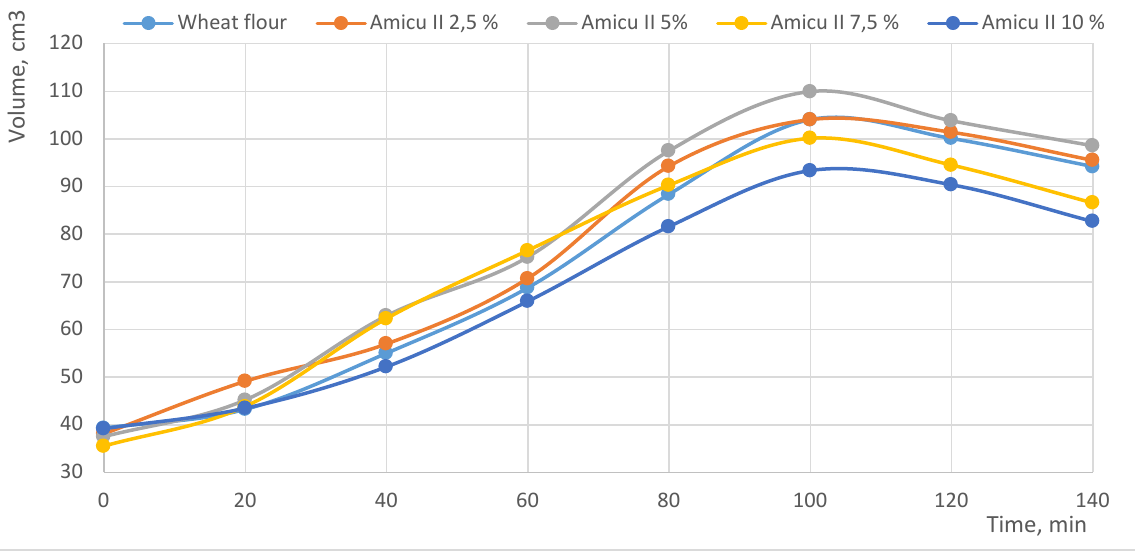
Figure 4b. The impact of the addition of Jerusalem artichoke flour on the volume of the dough during fermentation: dough from wheat flour (control sample,) dough from wheat flour-Jerusalem artichoke Amicu II variety in concentration of 2,5 %, 5%, 7,5% and